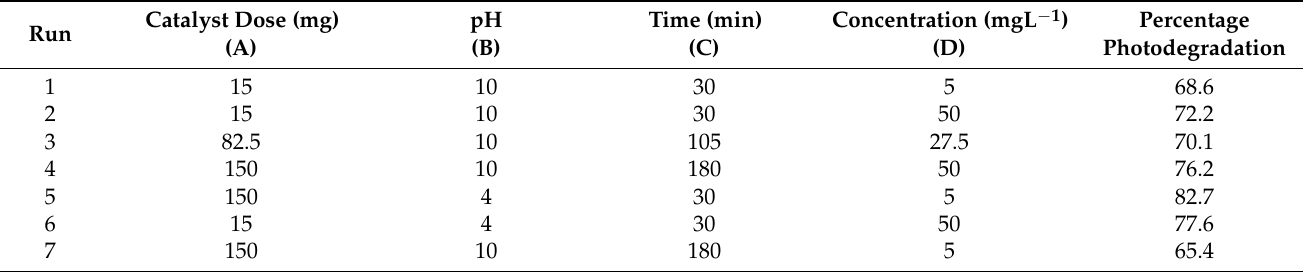
Figure 7. 3D surface plots representing the relationship between different variables and percentage photodegradation in case of BG dye. Table 2. Experimental runs for the prediction of optimum parameters using central composite